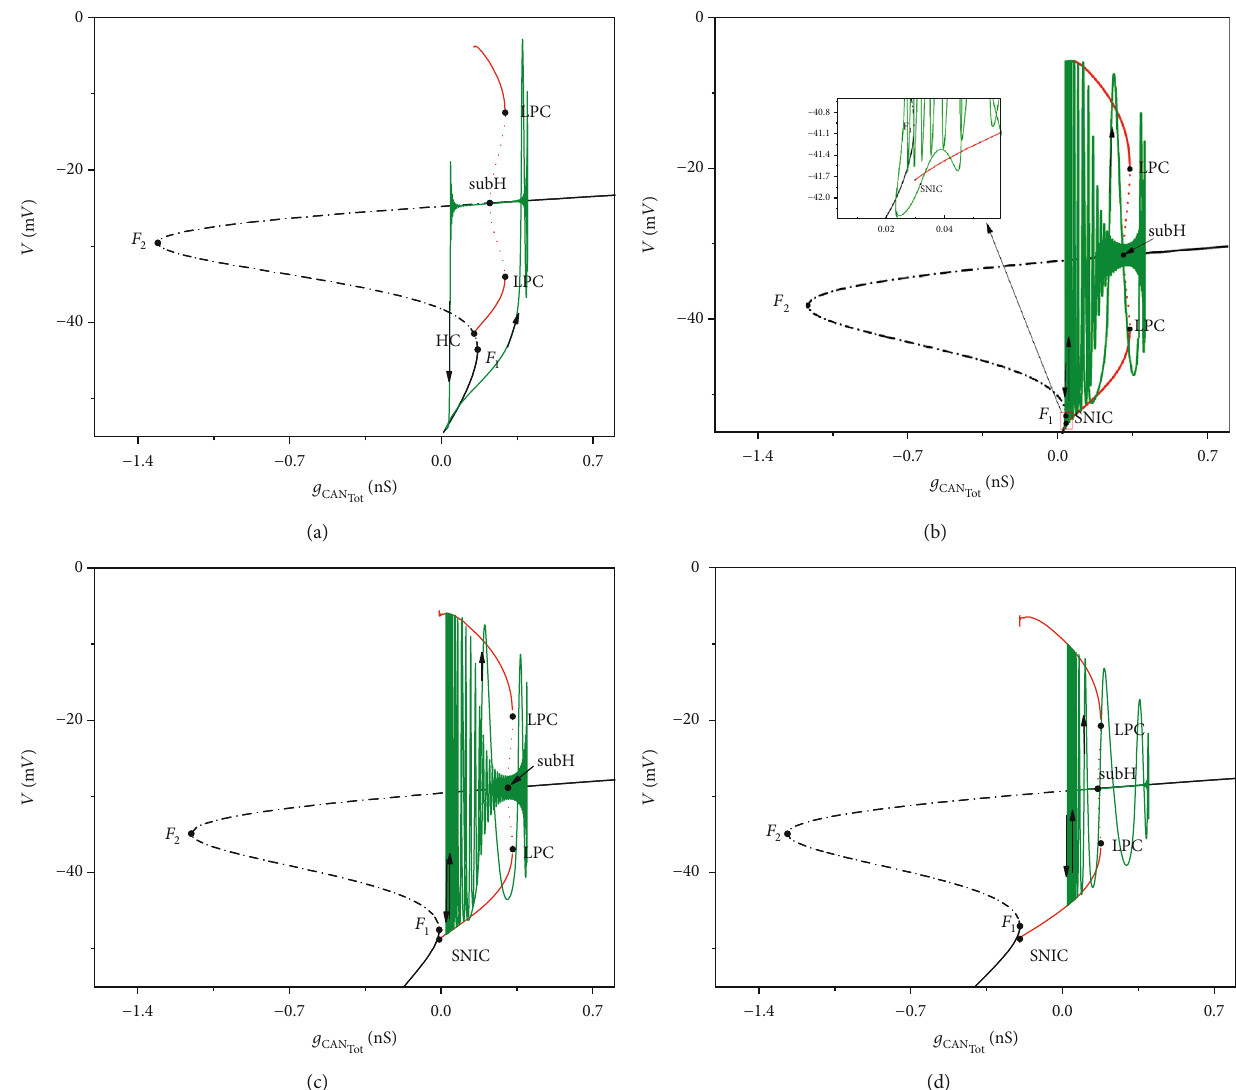
Figure 10: Fast-slow bifurcation analysis of neuronal fi ring patterns with di ff erent magnetic fl ow for (a) k = 1 : 5 k 1